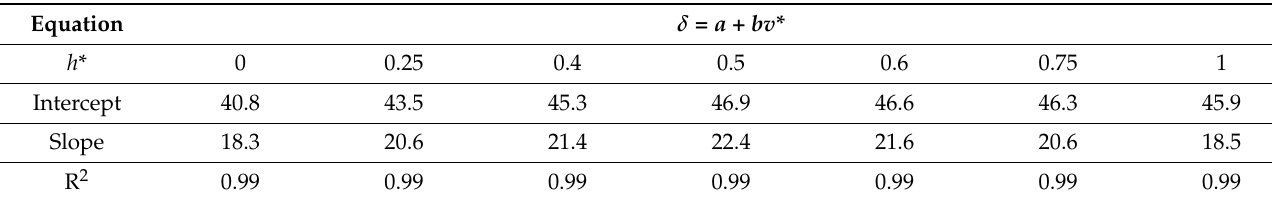
Figure 10. The relationship between δ and h * when Q is 3.0 MW. Table 1. Results between δ and v *.